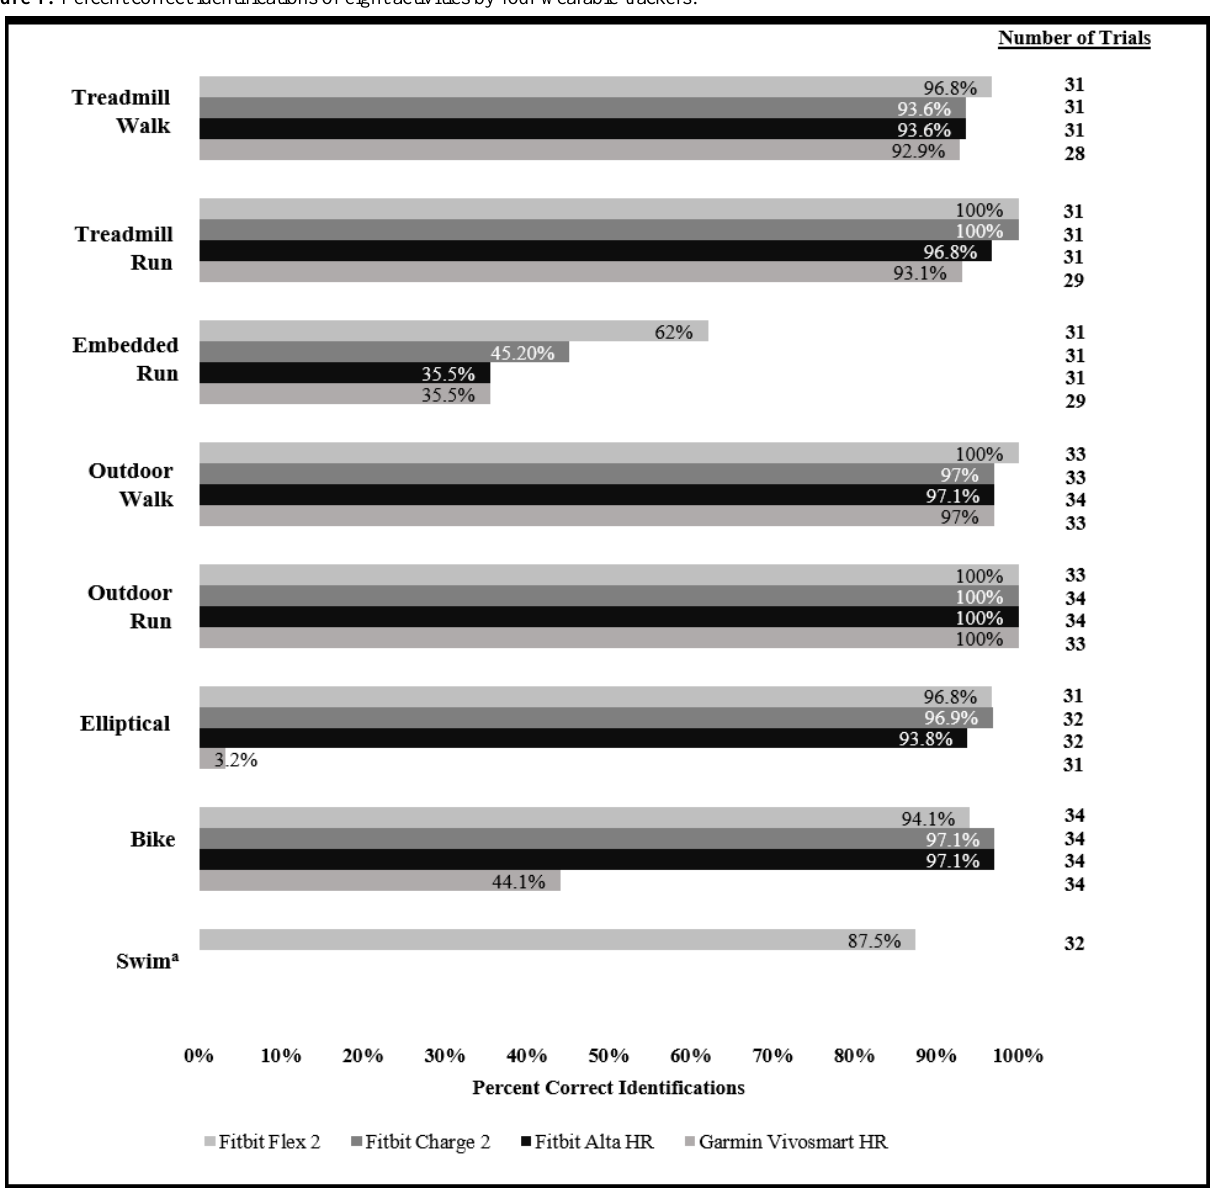
Figure 1. Percent correct identifications of eight activities by four wearable